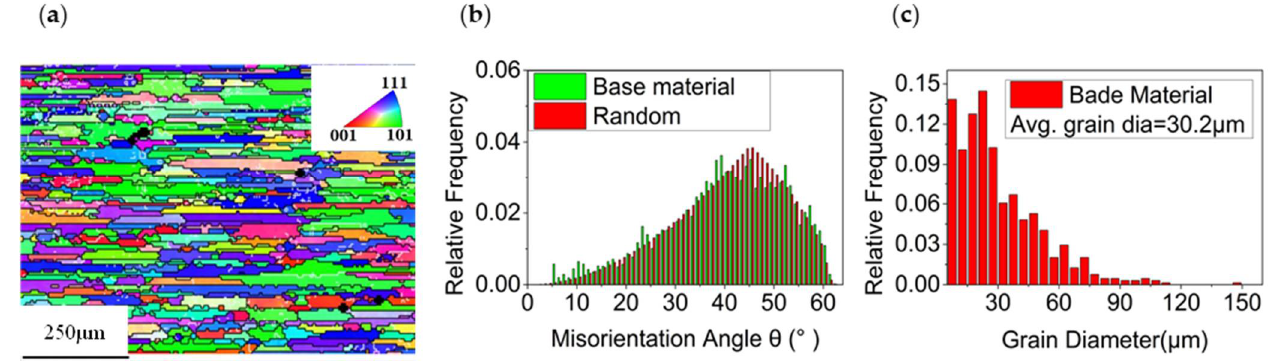
Figure 3. Grain morphology, misorientation angle and grain size of base metal. ( a ) Grain morphology. ( b ) Misorientation angle. ( c ) Grain size.